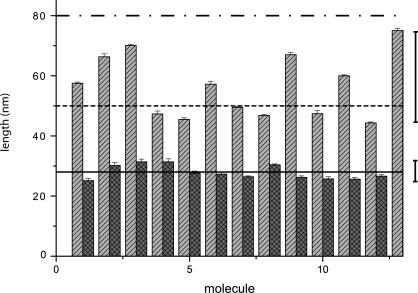
Contour Length Analysis of β-Like Force CurvesValues of the first peak position in force curves showing seven unfolding peaks. The height of each bar corresponds to the initial contour length of a single curve, obtained by fitting the first unfolding peak by means of the WLC model. The dashed line is the length corresponding to a protein construct with six I27 folded modules plus 95 aa of αSyn folded into a β-like structure, and the remaining 50 aa of αSyn unstructured (see Discussion section). The dashed-and-dotted line is the length corresponding to a protein construct with six I27 modules plus the 140 aa of αSyn completely unstructured. The lengths of twelve randomly chosen I27 modules have also been reported (dark gray columns) for comparison. The solid line is the nominal I27 contour length. The larger spreading of the αSyn data confirms the higher conformational heterogeneity. Side quotas show the difference between the maximum and minum observed length value for I27 (bottom) and β-like structures (top).